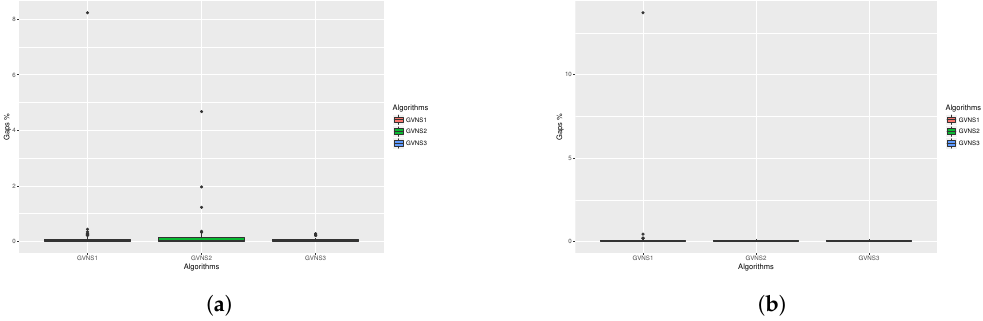
Figure 4. Statistical test for sTSP (2/2). ( a ) Statistical test box plots for sTSP 2min FI; ( b ) Statistical test box plots for sTSP 2min BI.